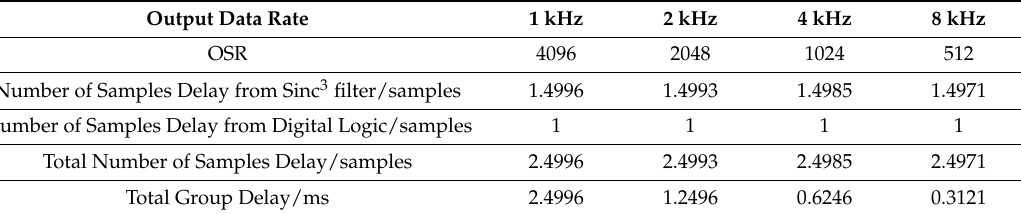
Table 2. Breakdown of the time delays from the sinc 3 filter and digital logic of the ADC for set values of the output data